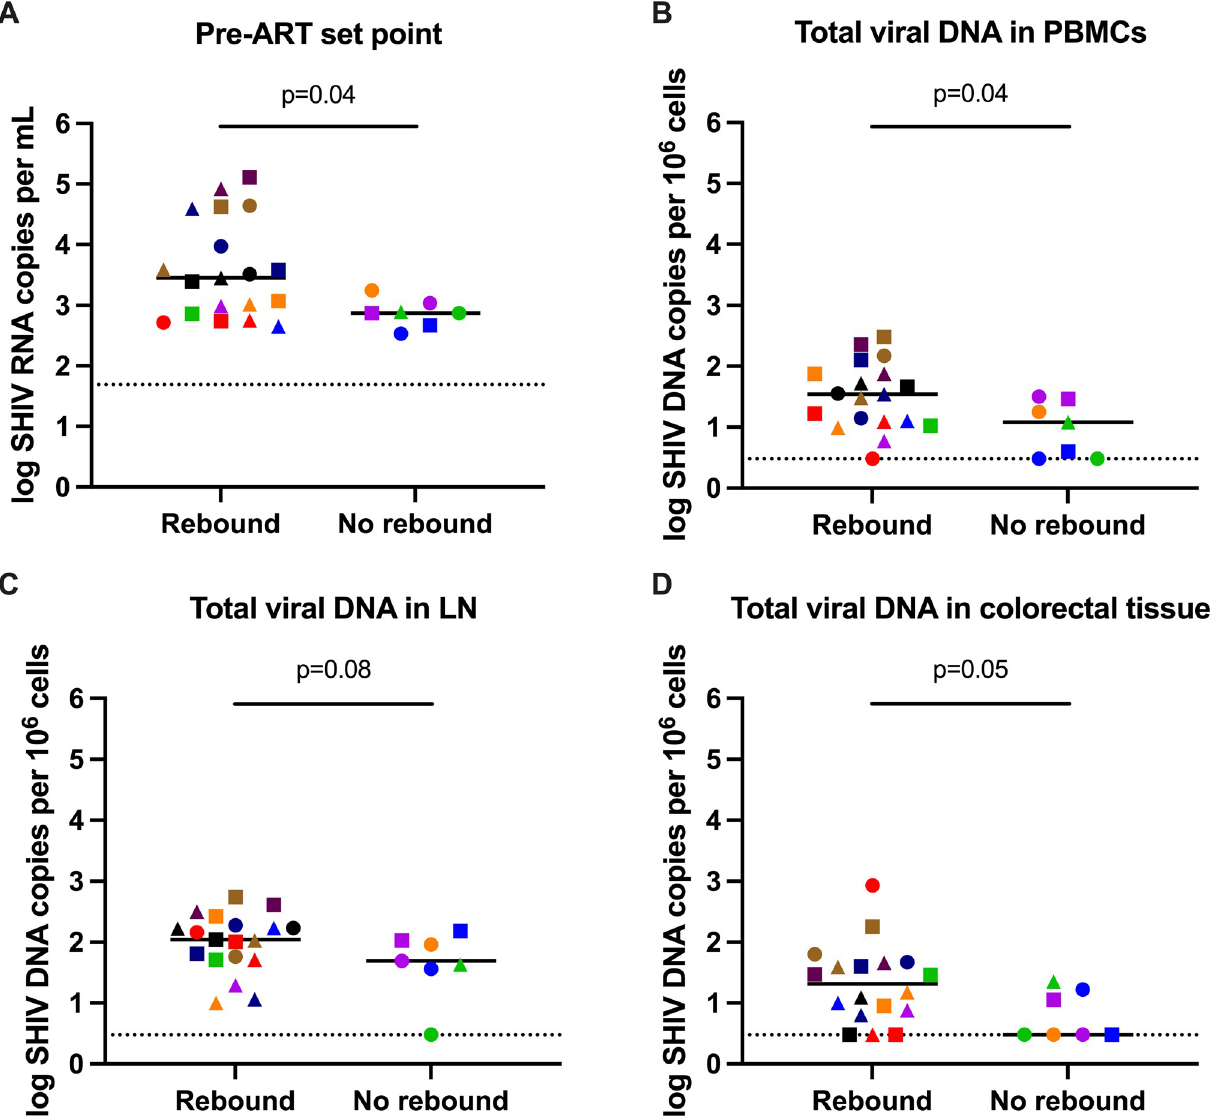
Fig 6. Analysis of viral rebound. Comparison of (A) pre-ART set point viral load, (B) total viral DNA in PBMCs, (C) total viral DNA in lymph nodes and (D) total viral DNA in colorectal tissue at week 32 for animals that rebounded and animals that did not rebound following ART discontinuation. Dotted lines indicate limit of detection, values on the line were below limit of detection. Black lines indicate median values. Individual symbol and color coding as indicated in S1 Table.